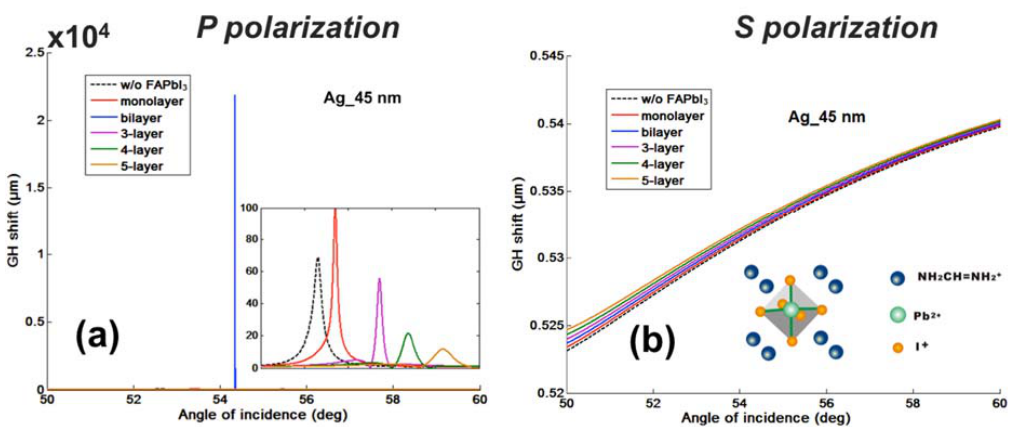
Figure 6. Comparison of the Goos–Hänchen (GH) ‐ SPR signal changes with 2D perovskites (FAPbI 3 ) layers under ( a ) p ‐ and ( b ) s ‐ polarization light excitation.